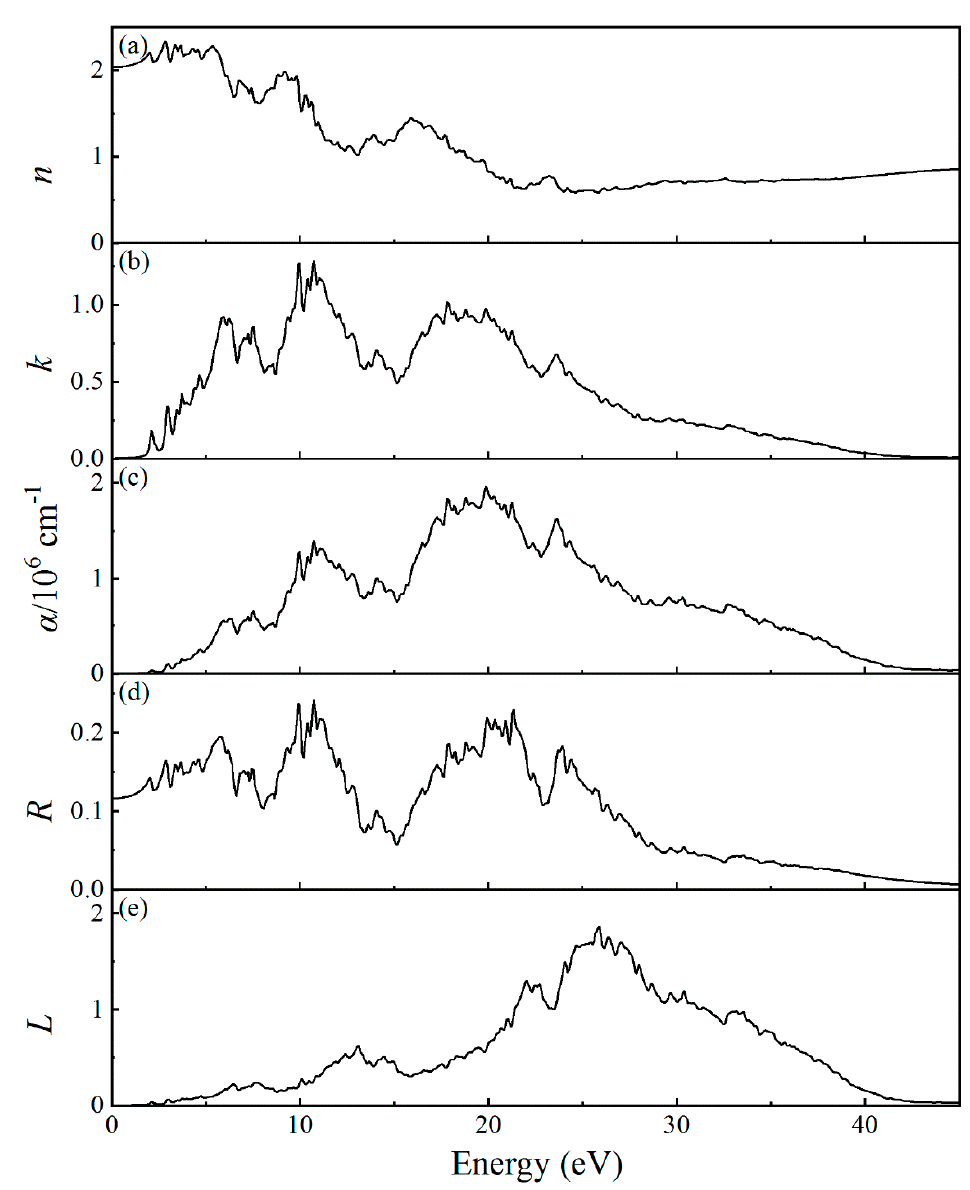
Figure 6. Calculated optical properties of MgBi 2 O 6 : ( a ) complex refractive index n , ( b ) extinction coefficient k , ( c ) absorption coefficient α , ( d ) reflectivity R , and ( e ) electron energy loss function L .